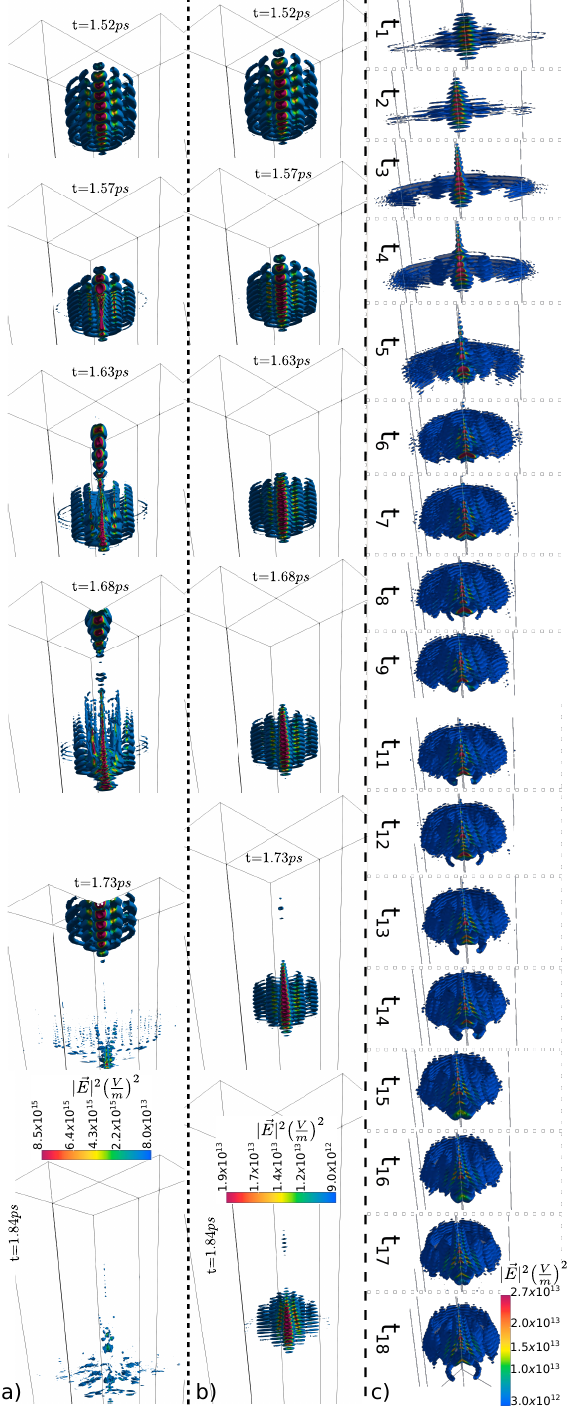
Figure 5. Propagation of the pulsed beam given by a time sequence of instants which has been plotted before reaching the theoretical critical power, with an energy per pulse of 2.8 µ J allowing to reach an electron density of 10 27 m − 3 , the beam splits, enclosing the charge and defocusing the beam. ( a ) Several instants of the pulsed square electromagnetic field when the power is beyond the critical power (High power regime). ( b ) Pulse propagation sequences during the travel inside the fused silica bulk for low power regime. ( c ) Sequence of frames that sketches the pulse along during its travel inside the fused silica bulk from the instance t 1 = 6290 ∆ t to t 18 = 9620 ∆ t (where − 16 s and Courant number 0.69). The difference between two time-steps is 200 ∆ ∆ t = 2.65765 × 10 in the sequence. The power of this sequence is in the threshold between low and high power regimes (critical